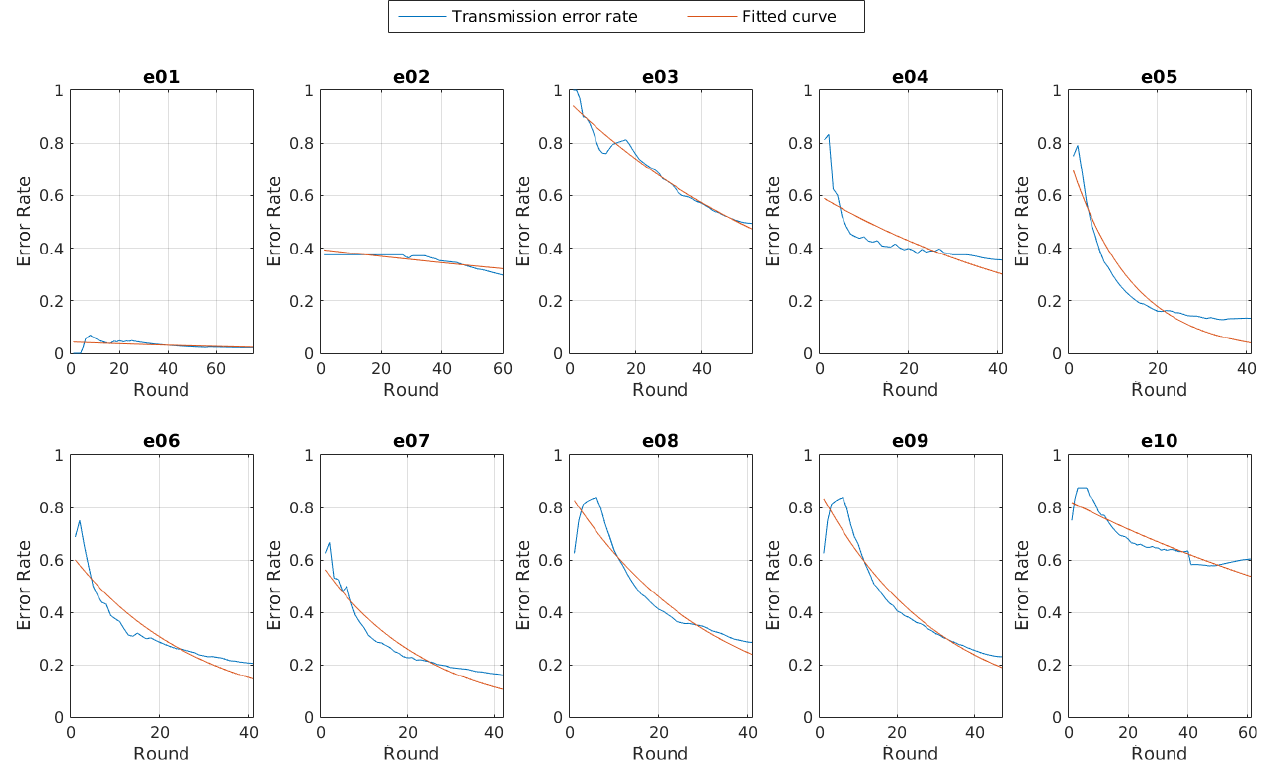
Figure 10. Evolution of the total transmission error rate per